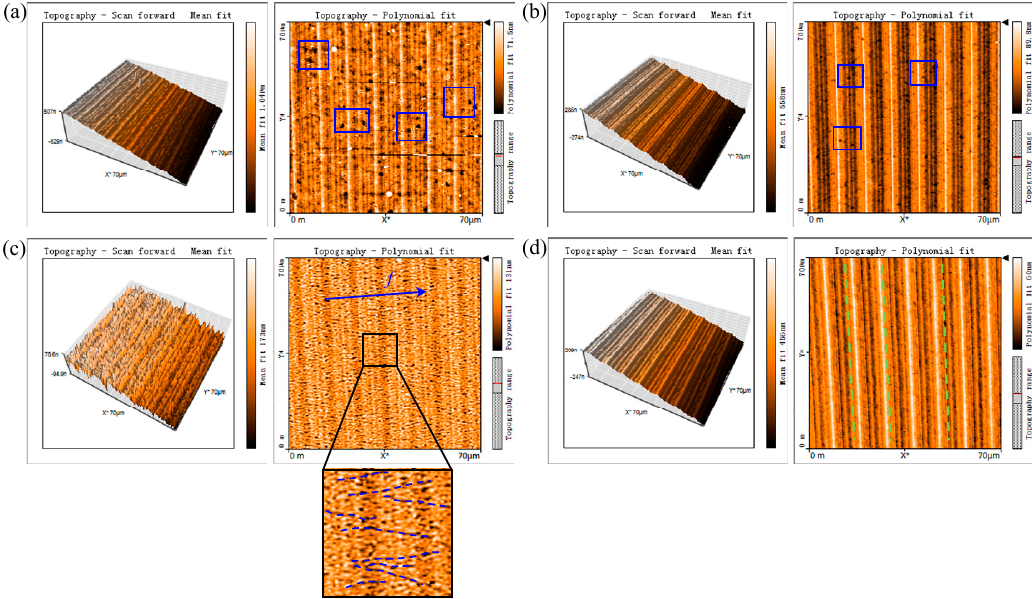
Figure 15. Machined surface in fly-cutting experiments of KDP crystal by different tool-edge qualities: ( a ) T0, freshly sharpened tool with tool-edge micro defects; ( b ) T1, passivated cutting edge in the traditional method at a depression angle of 0°; ( c ) T2, passivated cutting edge at a depression angle of 60°; ( d ) T3, chamfered cutting edge after passivation at a depression angle of 60° and re-sharpening of rake face.